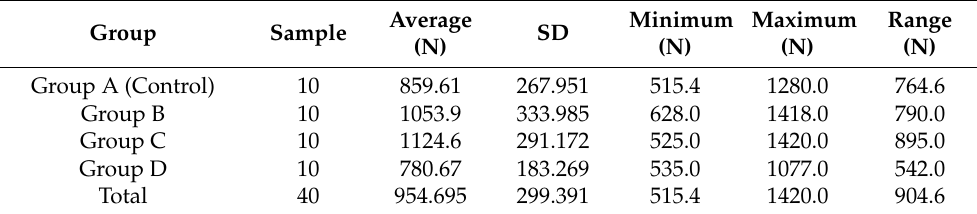
Table 1. Main fracture resistance in the different treatment groups. Group Sample